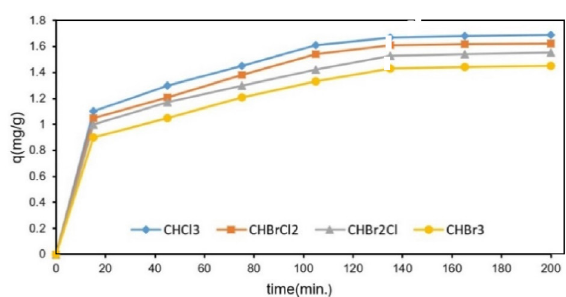
Figure 6C. Adsorption capacity of THMs over the time in the initial concentration of 5.0 mg/L and 10 mg adsorbent at 20 °C The maximum adsorption capacities of SMMT